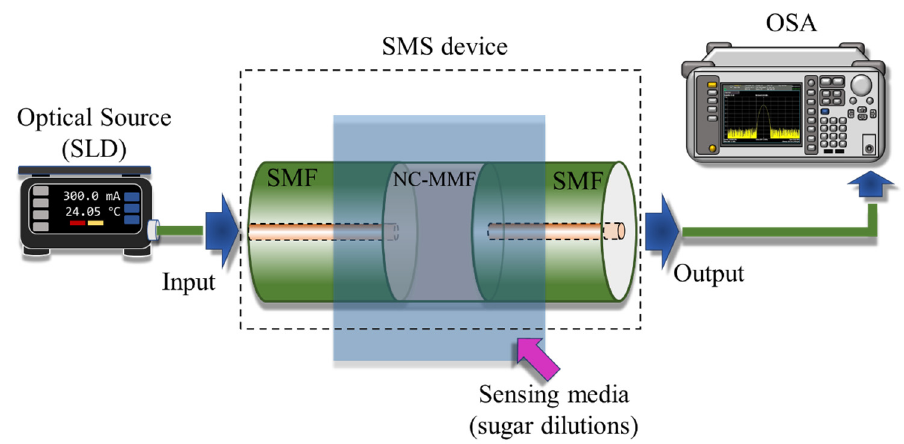
Figure 1. Experimental set-up used to measure sugar concentrations. In dotted rectangle, the SMS device is shown which is fabricated by splicing an NC-MMF segment between two SMF sections.